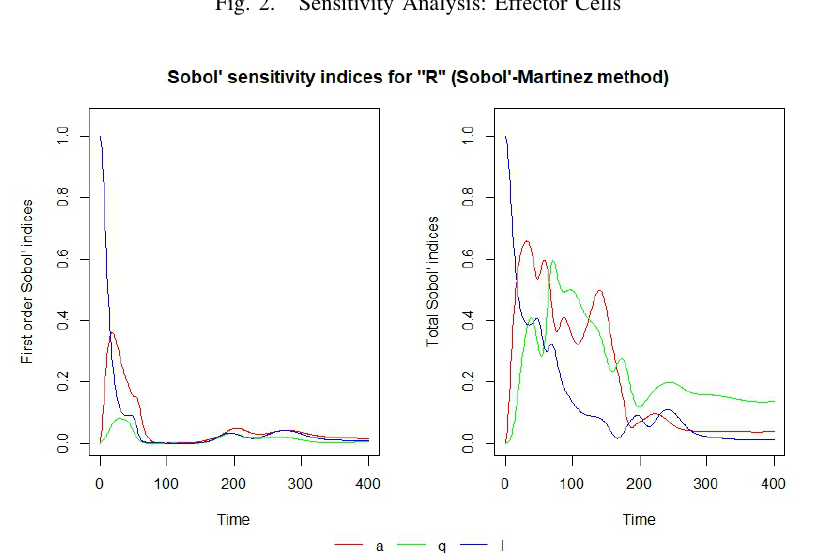
Fig. 3. Sensitivity Analysis: Resistant Cancer